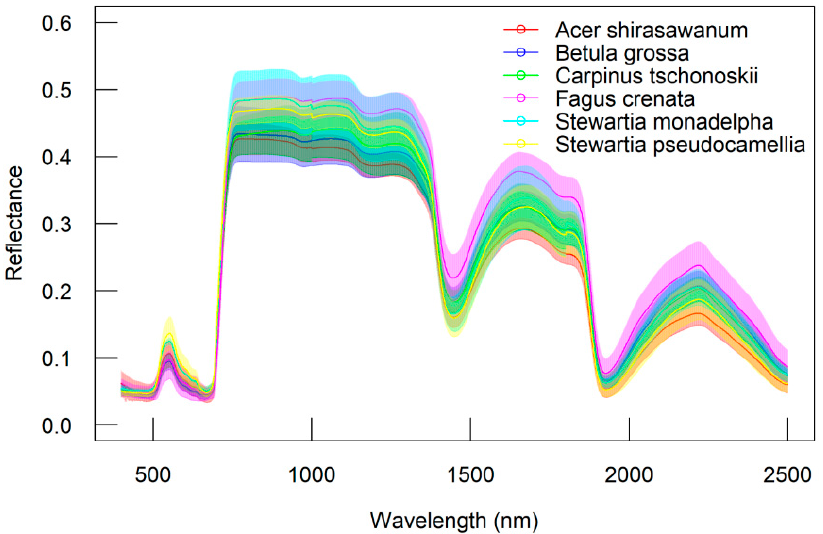
Figure 4. Variation of reflectance from each species. Lines represent mean of reflectance and the opaque zones represent standard deviations.